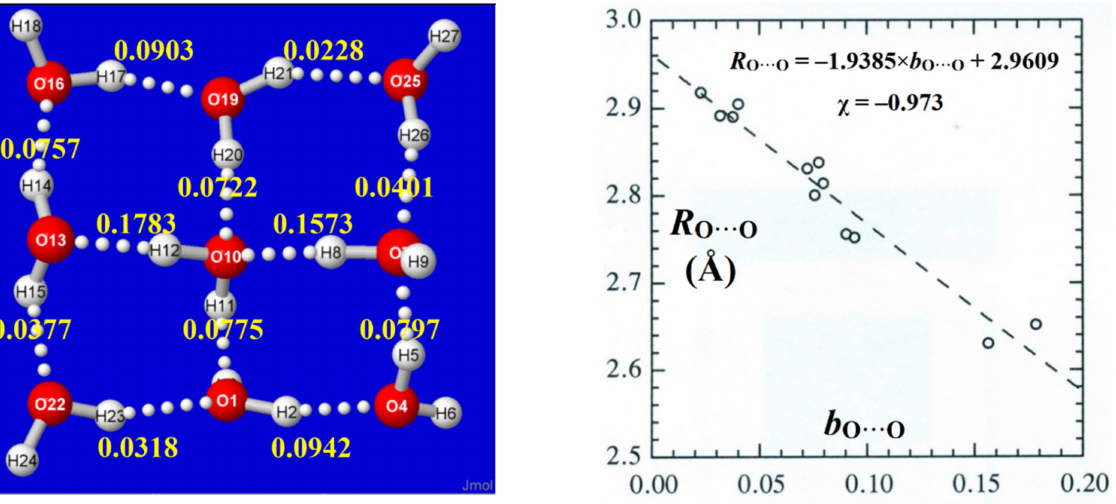
Figure 9. Calculated NRT bond orders b O ··· O of the 1,4,4 W 9 windowpane cluster ( left panel ), show- ing their excellent BOBL correlation (Pearson χ = − 0.973) with optimized R O ··· O bond lengths ( right panel